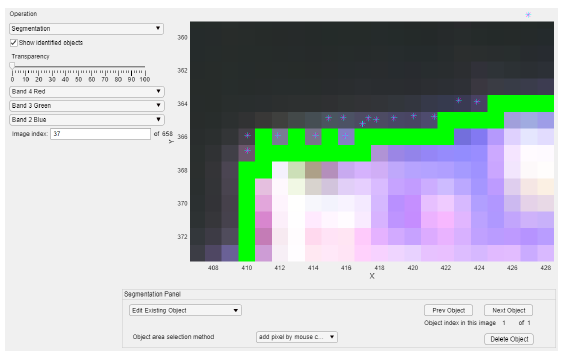
Figure 11. Pixel by pixel selection.